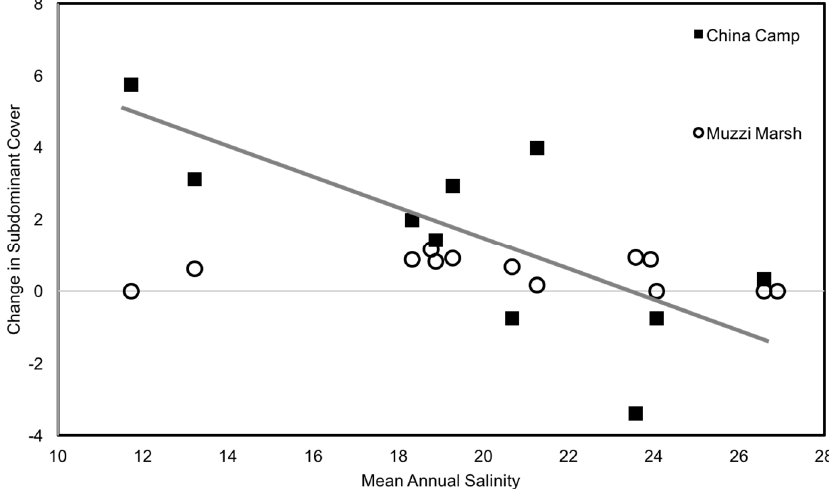
Figure 4. Sub-dominant change over mean annual salinity. We computed change in the sub-dominant community by subtracting the previous year’s total cover of sub-dominant species from the percent cover in the subsequent year. The relationship was significant at the reference site ( p = 0.012, f = − 9.894 df=1 ), but not significant at the restoration site ( p = 0.453, f = − 0.611 df=1 ). The line represents the fit for a univariate linear model but reported statistics in the text are for non-parametric generalized additive models.